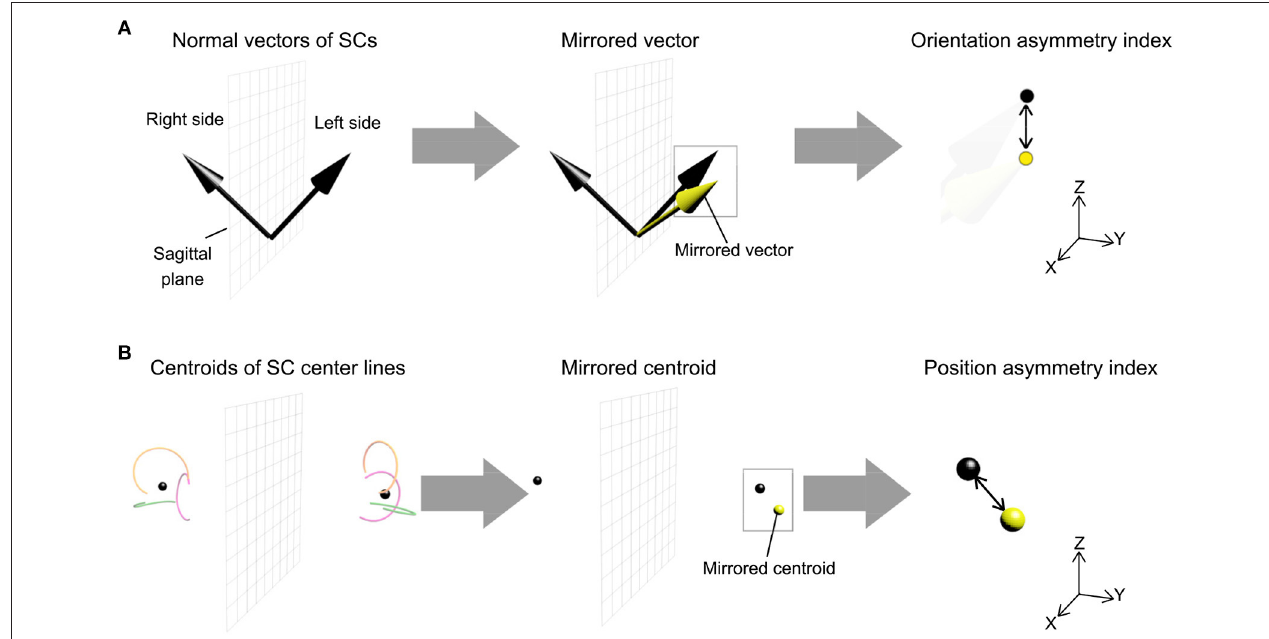
FIGURE 2 | Procedure for measurement of morphological asymmetry in the bilateral vestibular organs. The morphological asymmetry was evaluated using the orientation asymmetry index and the position asymmetry index. (A) The orientation asymmetry index was defined as the difference between the left-side normal vector of SC and the mirrored right-side normal vector of SC, the vector reflected in the sagittal plane. (B) The position asymmetry index was defined as the distance between a centroid of left-side SC centerlines and a mirrored centroid of right-side SC centerlines. Each side of the centroid corresponded to the mean position of a point cloud of three SC centerlines.